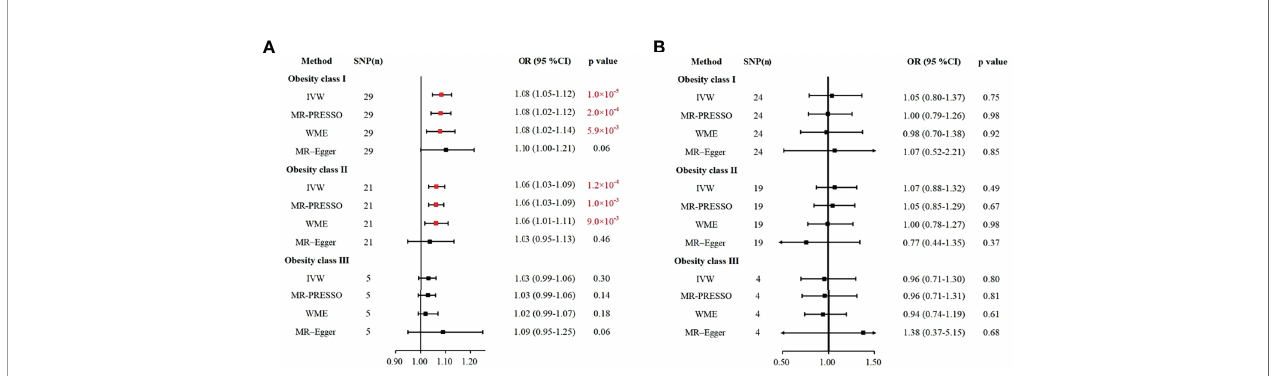
FIGURE 2 | Various methods to assess the impacts of obesity class I, obesity class II, and obesity class III on IS (A) and ICH (B) . (A) The causal effect of obesity and risk of IS. (B) The causal effect of obesity and the risk of ICH. IS, ischemic stroke; ICH, intracerebral hemorrhage; IVW, inverse-variance weighted; WME, weighted median estimation; MR-PRESSO, MR pleiotropy residual sum and